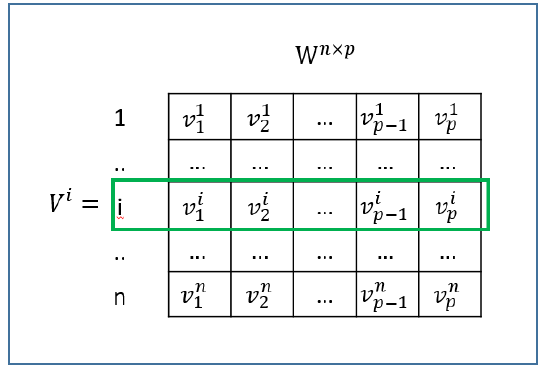
Figure 2. Embedding